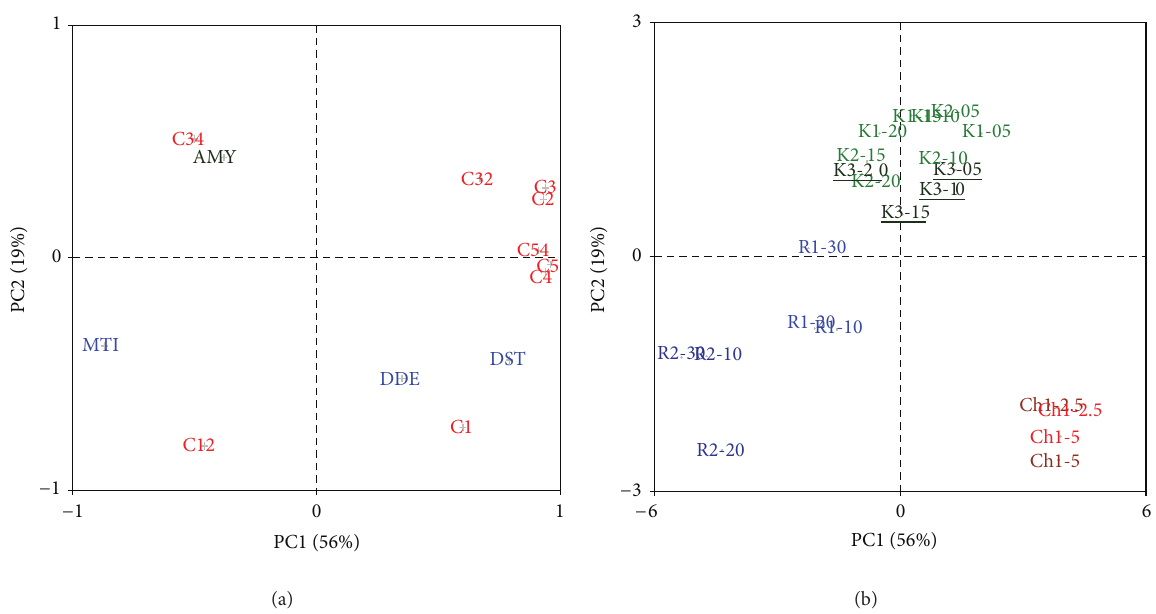
Figure 1: Comparison of rheological behaviour of wheat-hemp (K1, K2, K3), wheat-teff (R1, R2), and wheat-chia (Ch1, Ch2) composite flour by PCA. (a) variables loading plot—farinograph data: DDT: dough development time, DST: dough stability, MTI: mixing tolerance index; amylograph data: AMY: viscosity maximum; Mixolab torque data: C1–C5, and their pair differences C12, C32, C34, and C54. (b) Samples score plot.